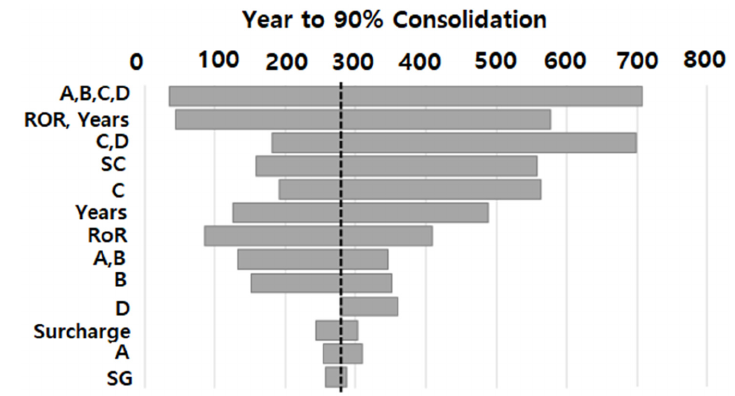
Figure 12. Years to 90% consolidation—after [54].